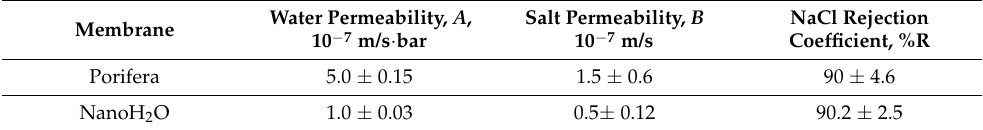
Table 1. Selective layer characteristics of the Porifera and NanoH 2 O membranes determined by cross-flow RO experiments at 22 ◦ C and 0.20–0.25 m/s cross-flow velocity. deionized water (DI water) water was fed at 3, 5, 7, 9 bar to measure the A values, and 2 g/L NaCl solution was used to measure the B and R values at 3, 5, 7